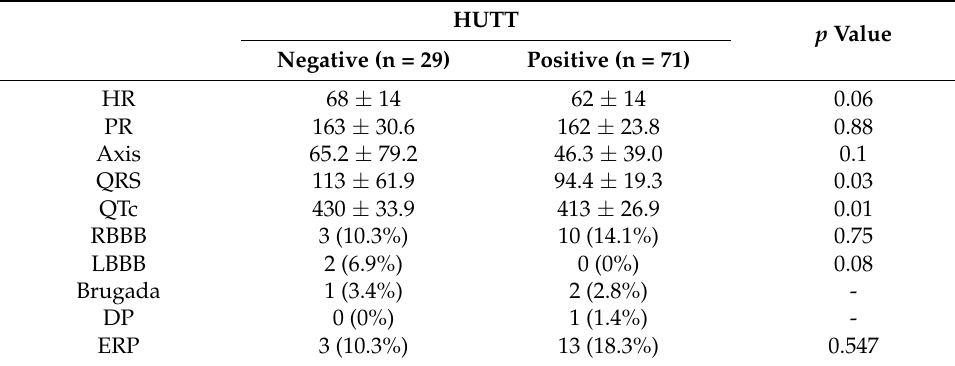
Table 2. Analysis of baseline electrocardiogram.